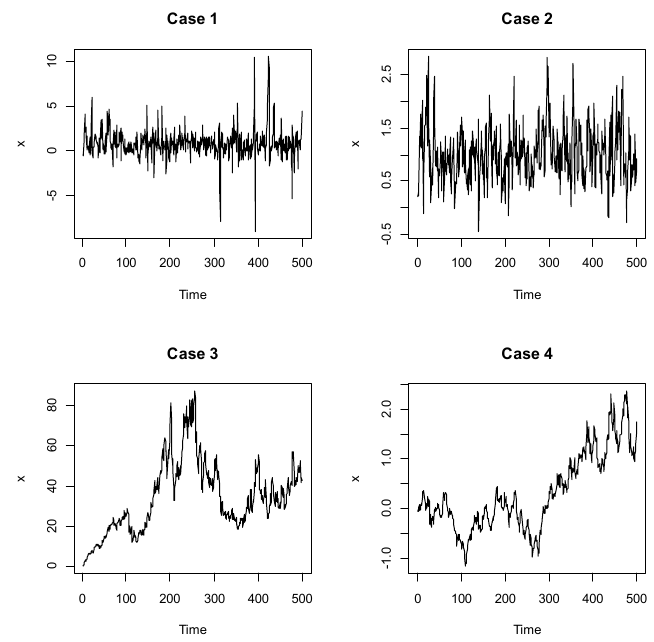
Figure 3. The time series plot of Case1–4 for generated data (500 sample sizes).